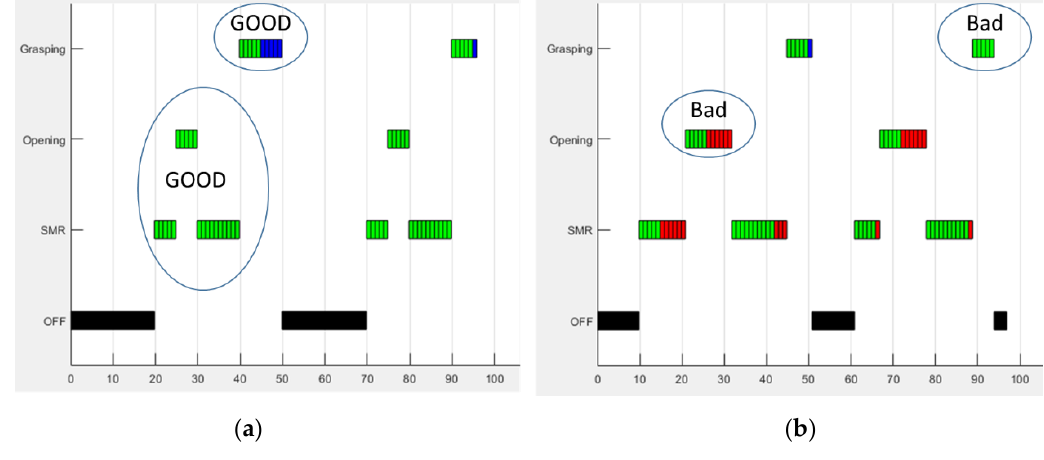
Figure 3. Graphical representations of good ( a ) and bad ( b ) trials.